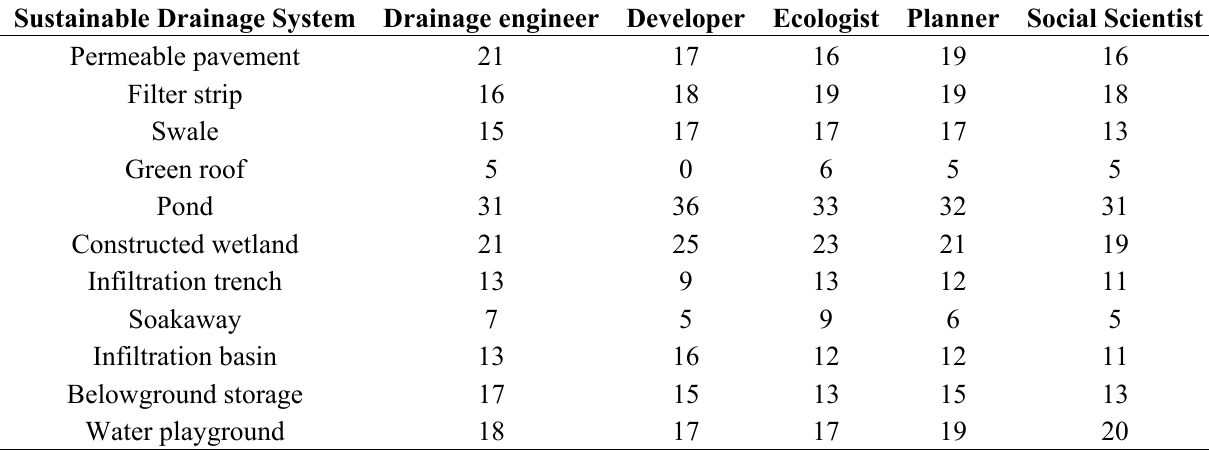
Table 5. Inter-site variability* comparison for a given sustainable drainage technique. Sustainable Drainage